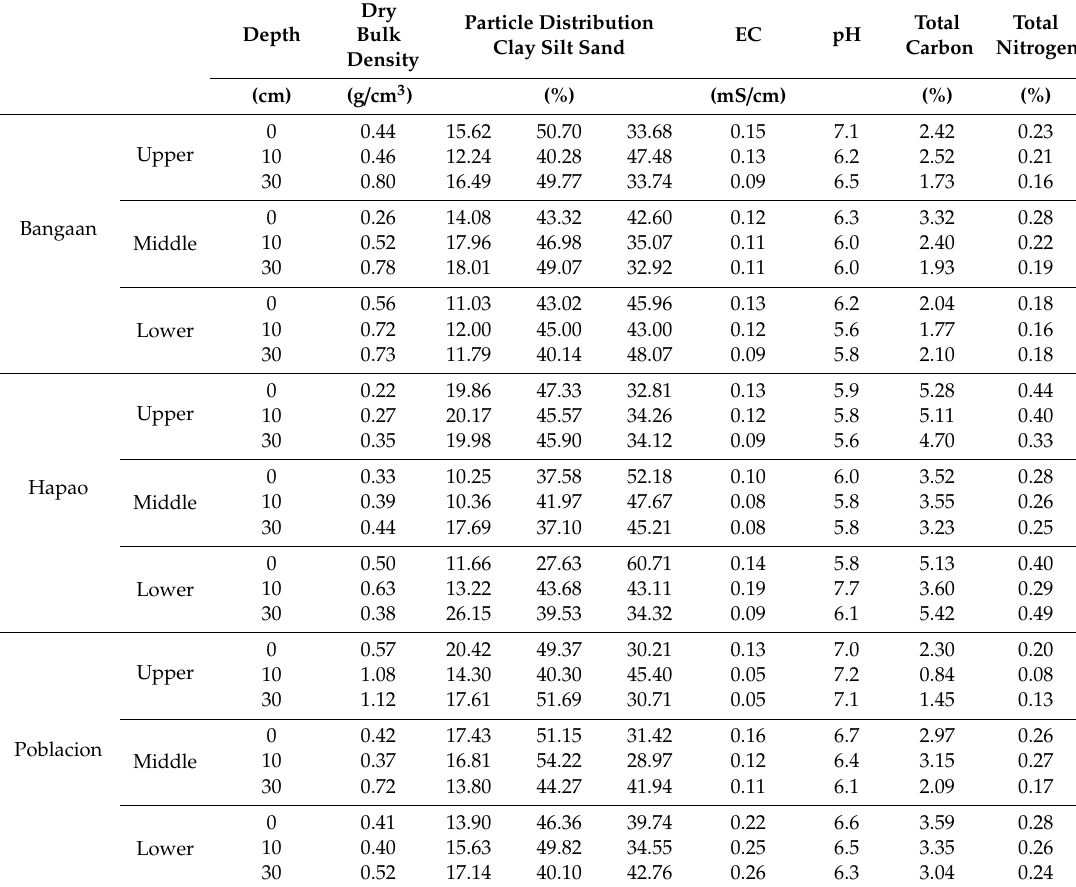
Table 1. Basic properties of soil samples from rice terraces in Bangaan, Hapao, and Poblacion.